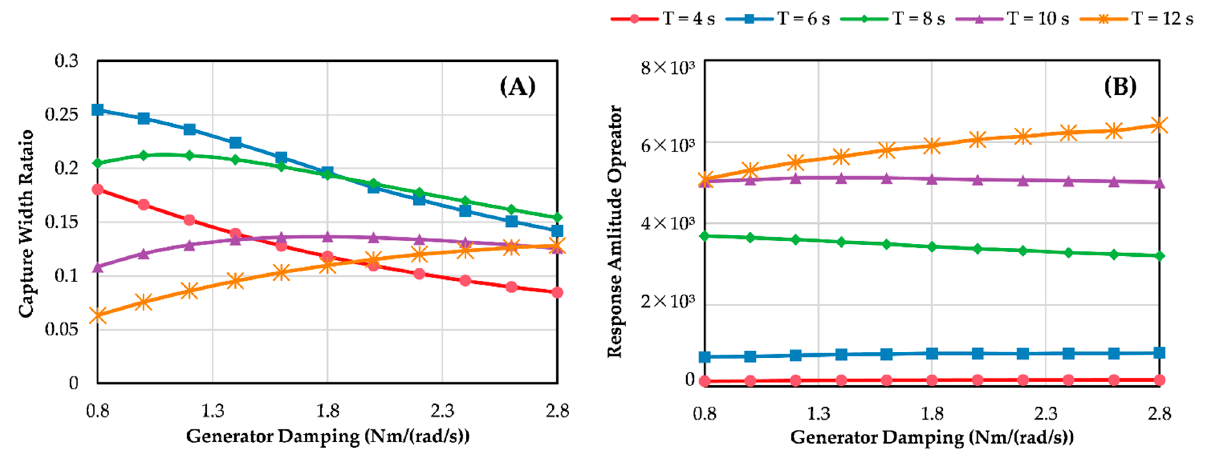
Figure 14. Influence of effective damping of generator on the performance of the hybrid system under wave height of 1.5 m. ( A ) Variation of CWR. ( B ) Variation of pitch motion RAO.